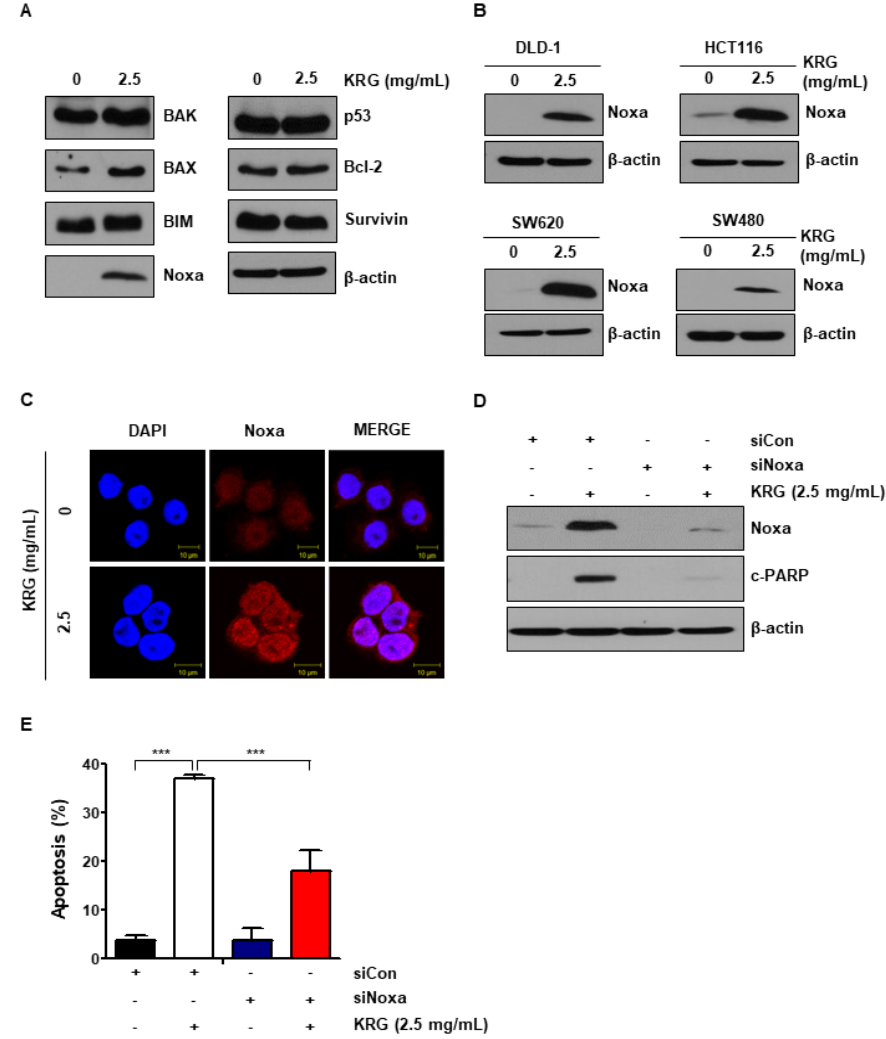
Figure 2. KRG extract enhanced apoptosis by regulating the expression of Noxa. ( A ) HT29 cells were treated with 2.5 mg / mL KRG extract for 48 h. The expression of pro-apoptotic proteins, such as BAX, Bak, Noxa, and BIM and anti-apoptotic proteins, such as Bcl-2 and survivin were detected by western blotting. ( B ) DLD-1, HCT116, SW620, and SW480 cells were treated with KRG extract (2.5 mg / mL) for 48 h. The expression of Noxa was confirmed by western blotting. ( C ) Noxa expression was observed by immunofluorescence and confocal microscopy. Scale bar: 10 µ m. ( D ) HT29 cells were transfected with control or Noxa siRNA. And then cells were treated with 2.5 mg / mL KRG extract for 48 h. The expression of Noxa and cleaved PARP was analyzed by western blotting. ( E ) HT29 cells were transfected with control siRNA or Noxa siRNA. The cells were then treated with 2.5 mg / mL KRG extract for 48 h and stained with annexin V / PI. The rate of cell apoptosis was assessed by flow cytometry. The data are shown as the mean of many repeated independent experiments. *** p <